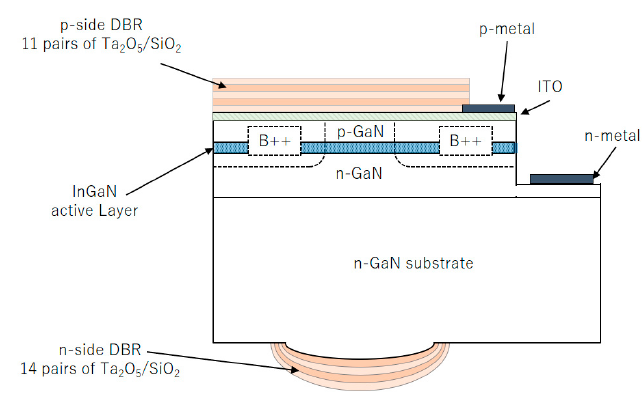
Figure 6. Schematic of a GaN-VCSEL having a curved mirror [16].